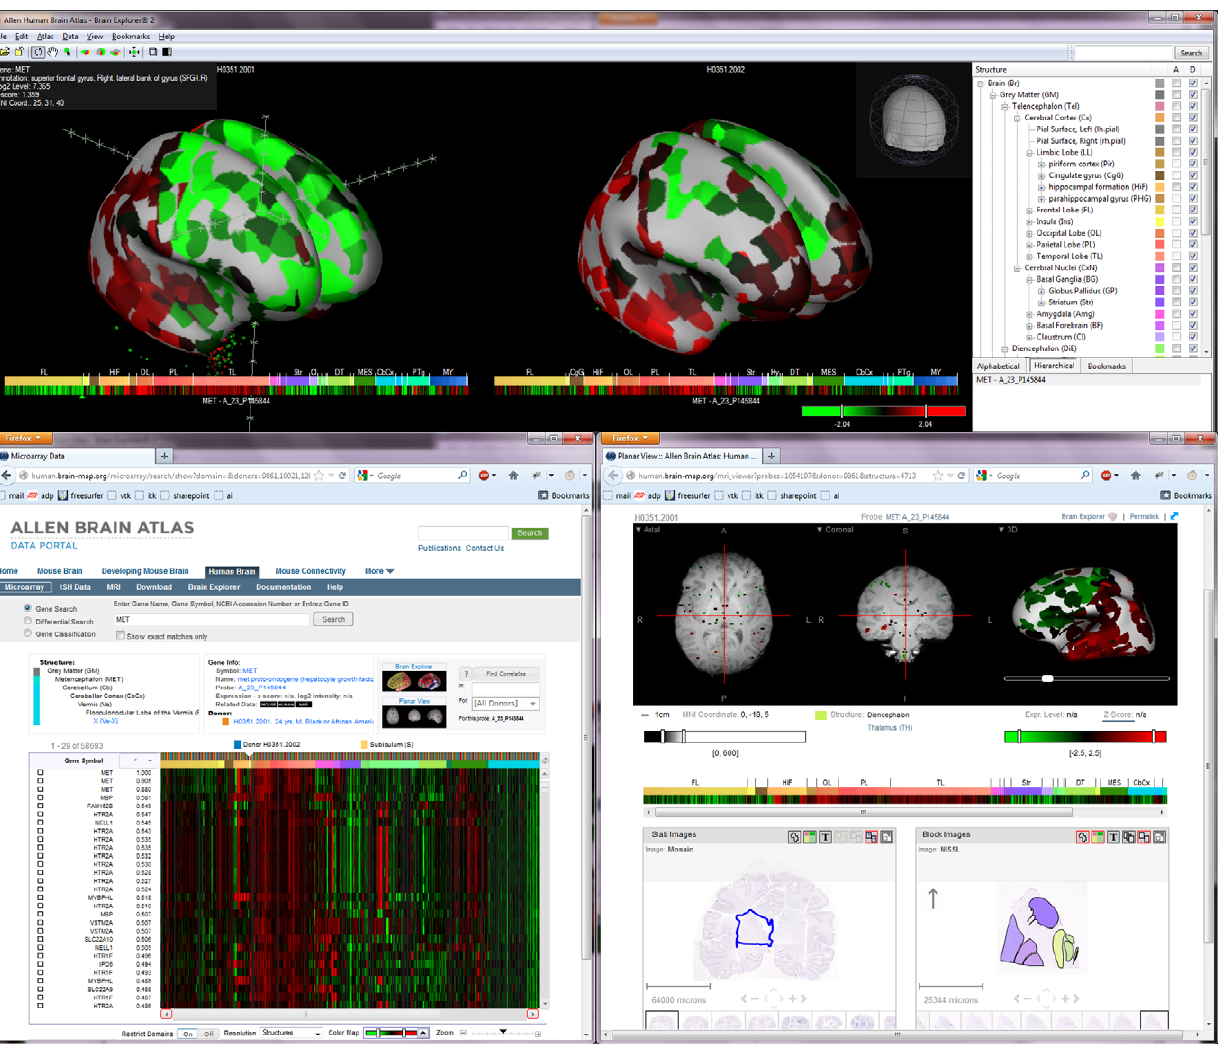
Figure 1. The Allen Human Brain Atlas contains multimodal data integrated into a unified 3-D framework with search and visualization features allowing one to journey through the brain readily climbing up and down levels of resolution. See it in action: Check out video tutorials on the Allen Human Brain Atlas and Brain Explorer H 3-D Viewer. Key Features: An ‘‘all genes, all structures’’ gene expression survey in multiple adult control brains. N . 62,000 gene probes per profile. N , 500 samples per hemisphere across cerebrum, cerebellum, and brainstem. N Data mapped with histology into unified 3-D anatomic framework based on MRI. High-resolution ISH image data covering selected genes in specific brain regions. N Subcortex Study: 55 genes across subcortical regions and 10 additional genes in hypothalamus in one male and one female donor. N Cortex Study: 1,000 genes in visual and temporal cortices in multiple adult control brains. N Schizophrenia Study: 60 genes in dorsolateral prefrontal cortex of over 50 control and schizophrenia cases. N Autism Study: 25 genes in frontal, temporal and occipital cortical regions of 11 control and 11 autism cases. N Neurotransmitter Study: Selected neurotransmitter system genes in major cortical and subcortical areas in adult control brains. MRI data for brains used for all microarray and some ISH analyses. Search and viewing tools, including: N Brain Explorer H 3-D viewer. N Heatmap viewer for exploring microarray data across genes and brain regions. N Gene-based and anatomic search features. N Multiplanar MRI viewer with gene expression overlay. N Linked viewing of MRI, gene expression, histology, anatomic delineations.